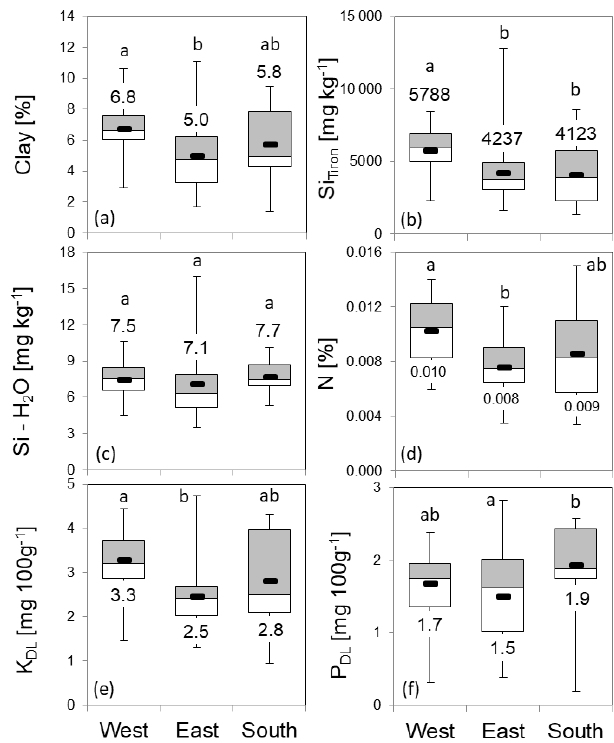
Figure 10. Soil properties and nutrients at grid points in the west- ern, eastern and southern zones (box plots: mean, upper and lower quartiles; minimum; and maximum). Figures depict the distribution of clay content (a) , Tiron-extractable amorphous Si (SiTiron) (b) , water-soluble Si (Si – H 2 O) (c) , nitrogen (d) , potassium (e) and phosphorus (f) . Numbers represent zonal means. The letters “a” and “b” indicate statistical significance of differences between zones ac- cording to Kruskal–Wallis ANOVA ( p < 0 .